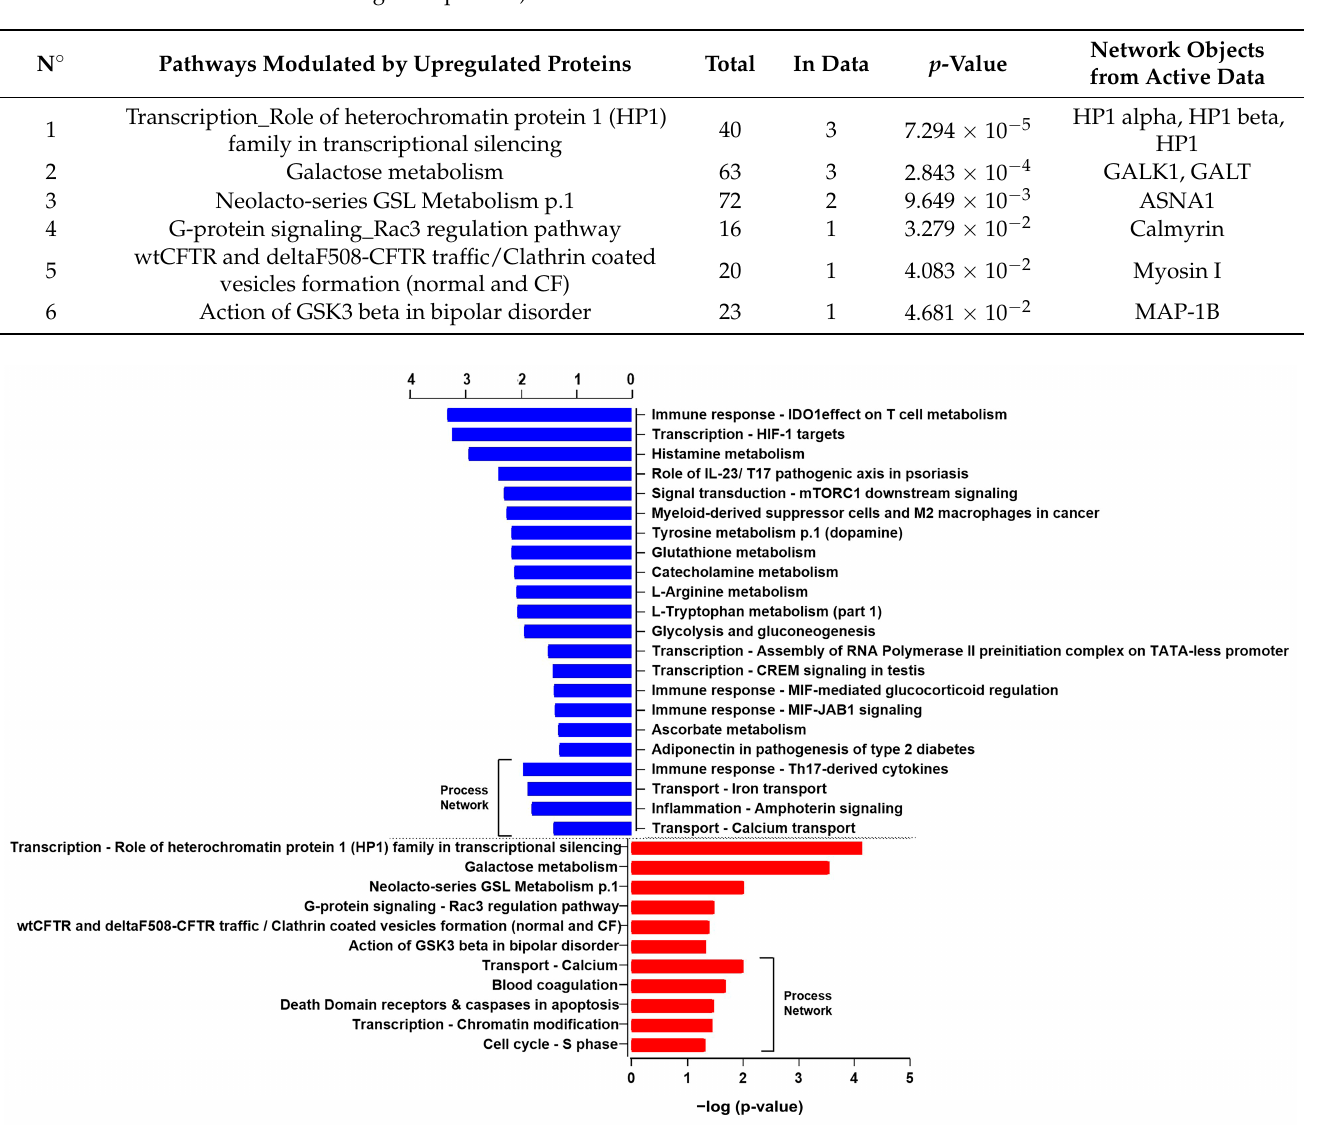
Table 4. MetaCore enrichment analysis of proteomics data in LNCaP PCa cells overexpressing miR- 423-5p. Significant process networks modulated by upregulated proteins in LNCaP PCa cells expressing miR-423-5p mimic compared to control (empty vector) ( p -value ≤ 0.05). Quantitative SWATH-mass spectrometry data analysis performed with the SCIEX OneOmics cloud processing platform (n = 6 biological replicates).